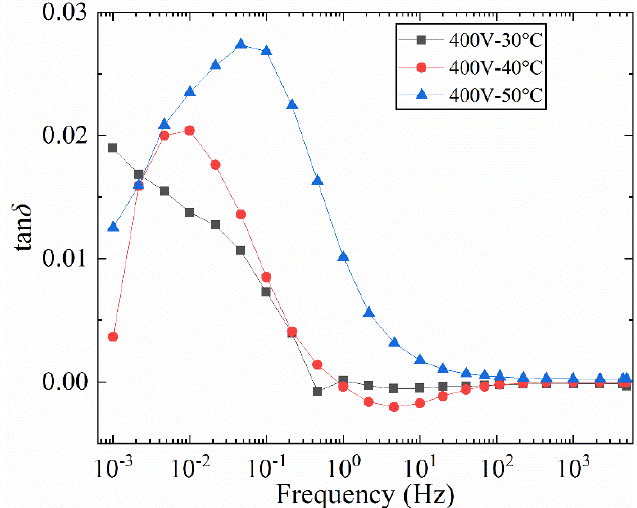
Figure 14. Influence of different temperatures on the difference of tan δ - f curve at the same voltage.